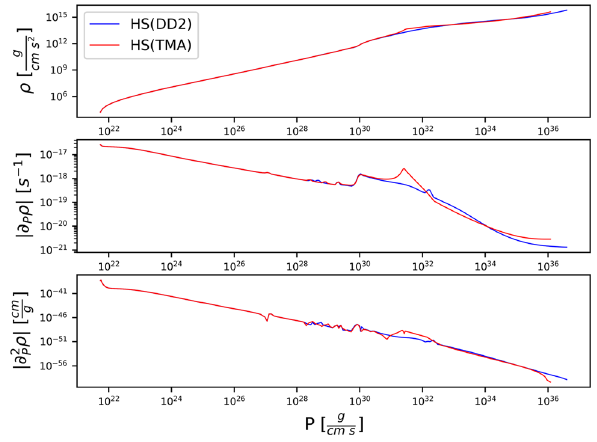
Fig. 9 The EoS used in this paper (first panel) together with their first and second derivatives (second and third panel respectively)